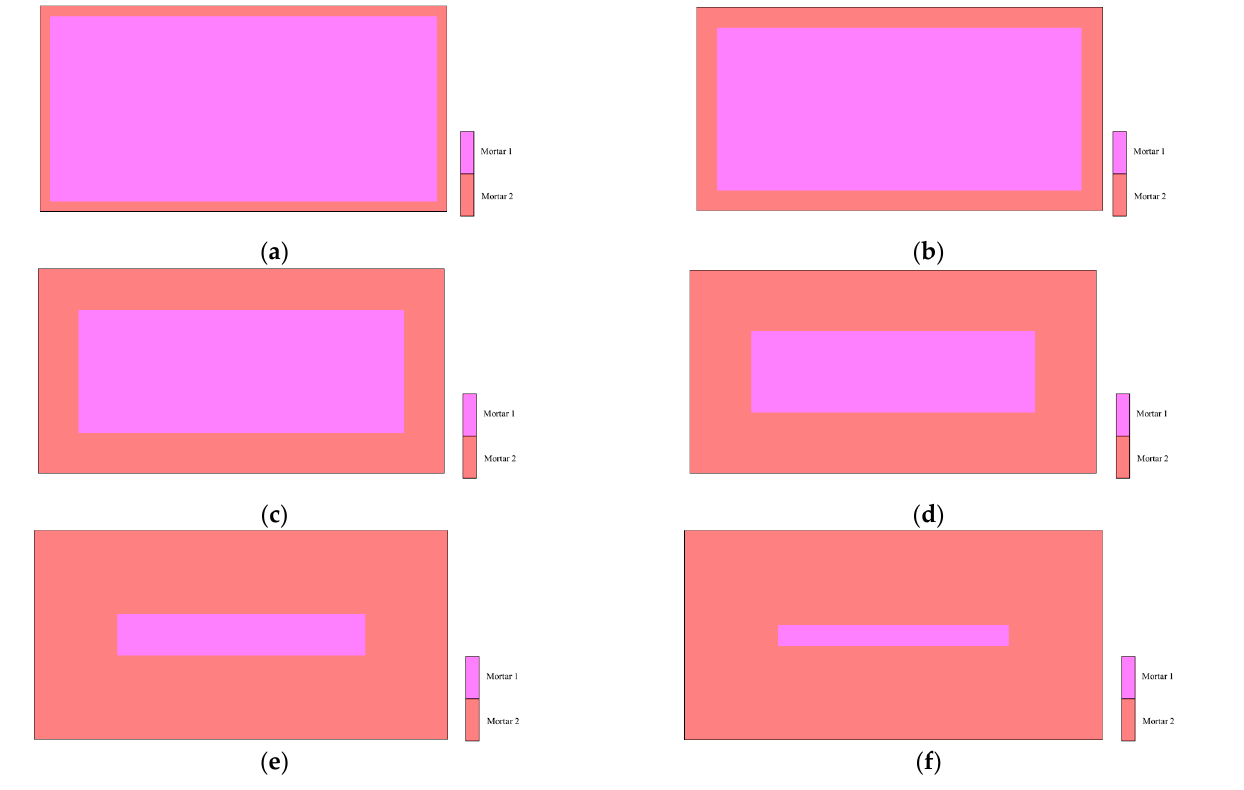
Figure 9. Measured waveform: ( a ) analysis model (dry depth = 5 mm), ( b ) analysis model (dry depth = 10 mm), ( c ) analysis model (dry depth = 20 mm), ( d ) analysis model (dry depth = 30 mm), ( e ) analysis model (dry depth = 40 mm), and ( f ) analysis model (dry depth = 45 mm).